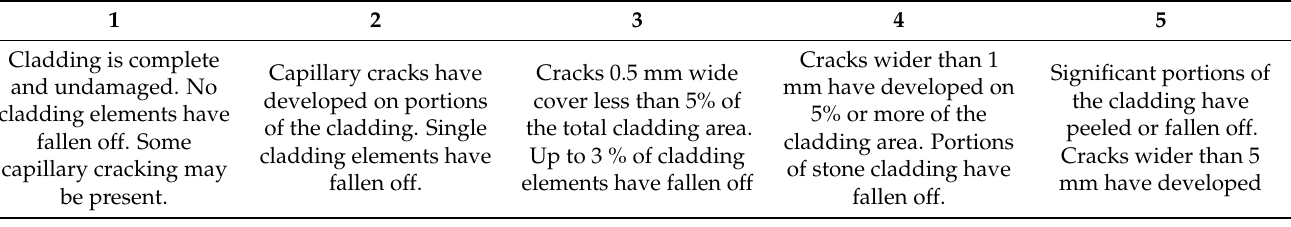
Table A2. Safety grading criteria